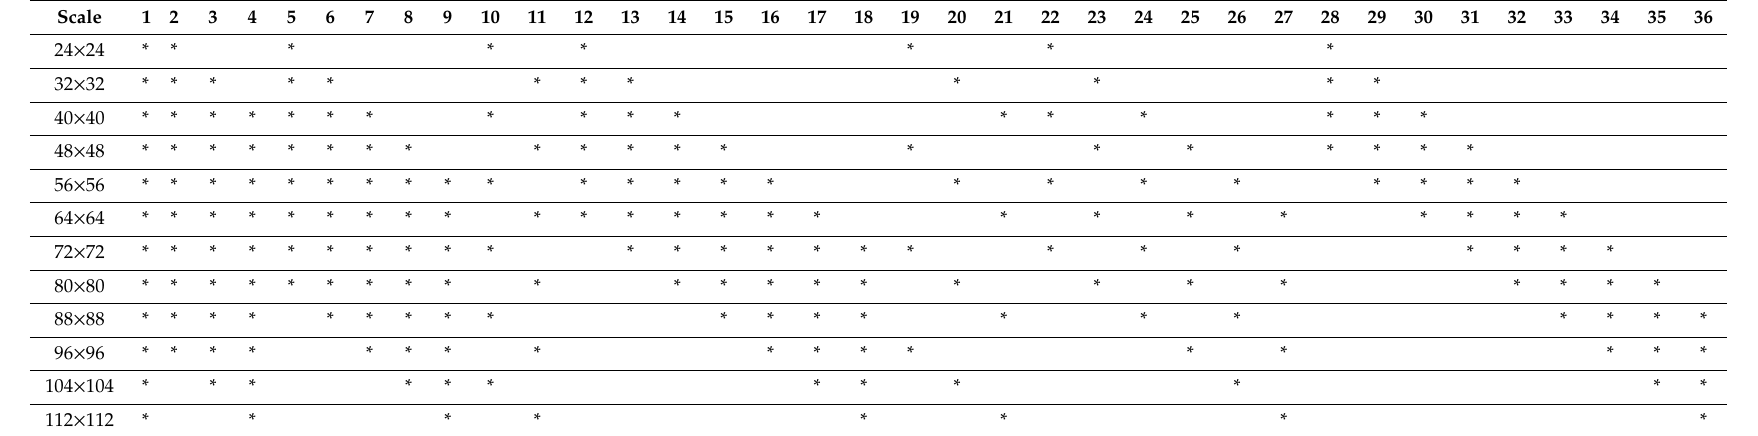
Table 2. Multi-scale combining solutions based on single-scale convolutional neural network (CNN) features for high spatial resolution (HSR) land-cover classification.